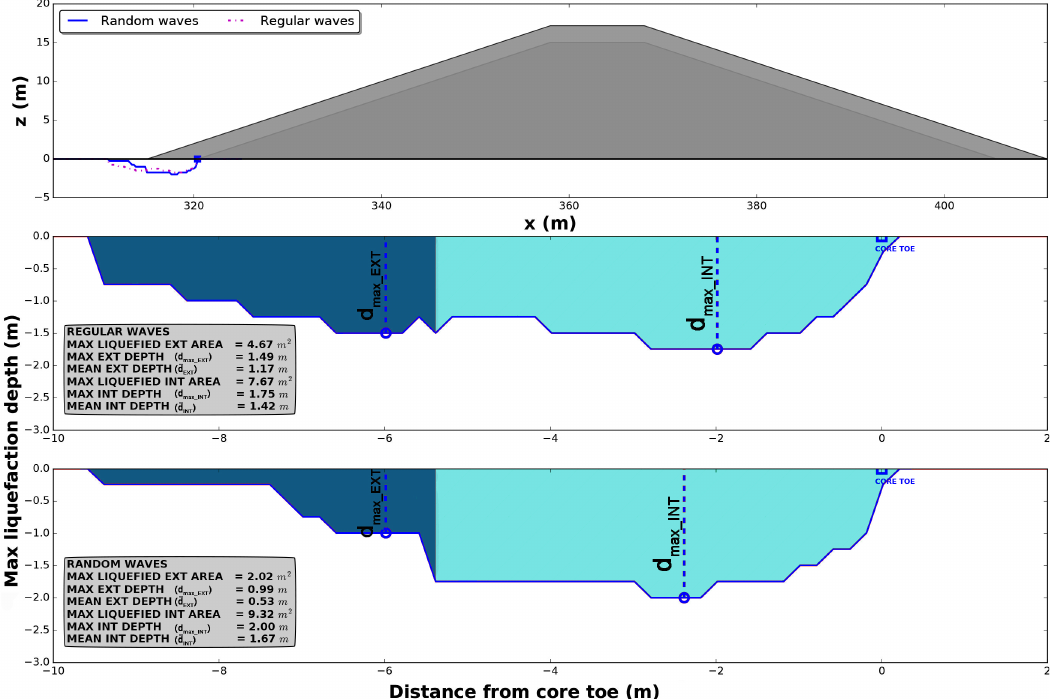
Figure 8. Wave-induced momentary liquefaction concerning a straight sloped conventional rubble mound breakwater without a berm. Upper panel: maximum depth of momentary liquefaction induced by regular and random waves around and beneath the structure. Middle panel: zoom of the maximum liquefied area induced by regular waves splits into two zones, in accordance with the location of the liquefaction occurrences. Blue subareas refer to maximum liquefaction depth ahead of the structure, down to the breakwater toe. Cyan subarea refers to maximum liquefaction depth below the structure. Lower panel: zoom of the momentary liquefaction maximum area induced by random